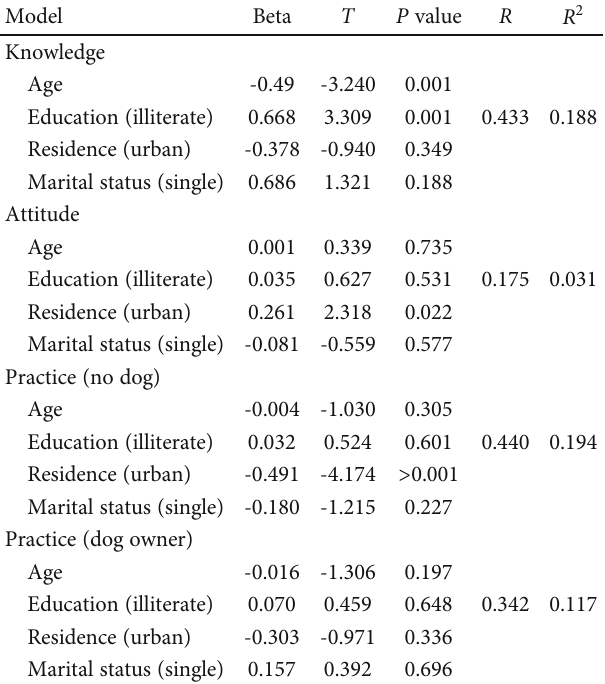
Table 4: Additional questions regarding participants ’ perspective towards